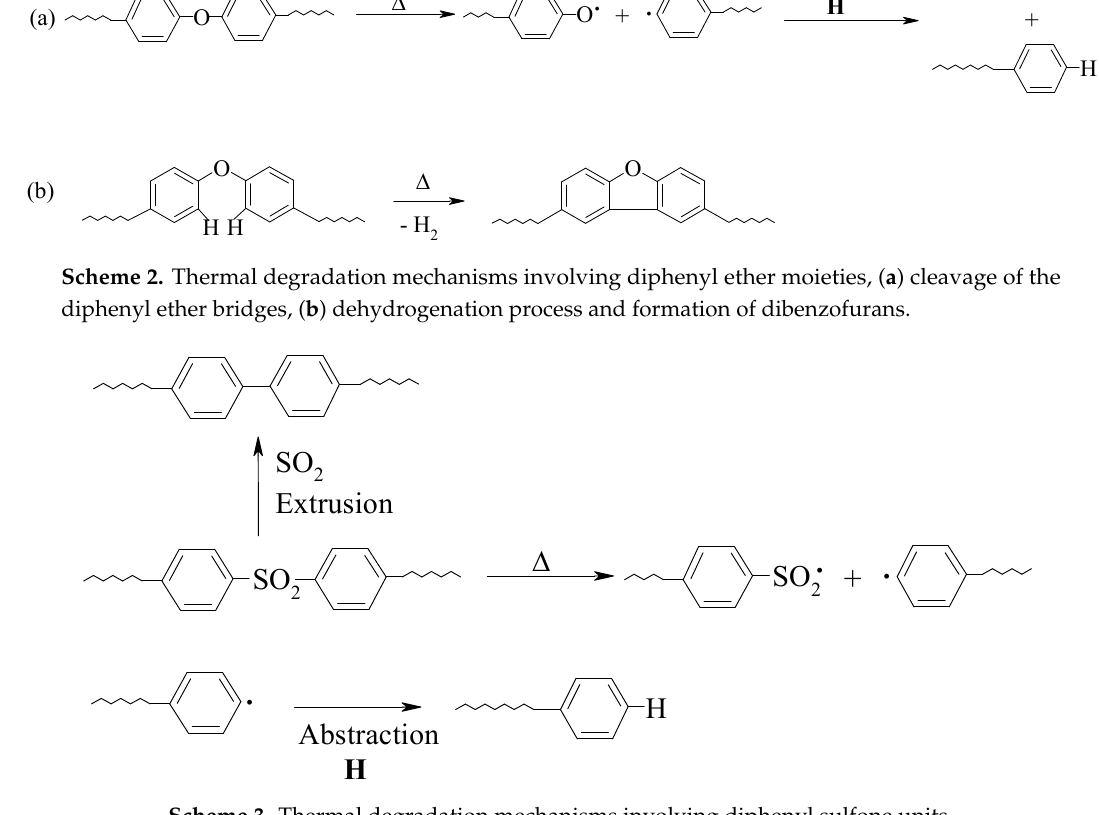
Scheme 3. Thermal degradation mechanisms involving diphenyl sulfone units.